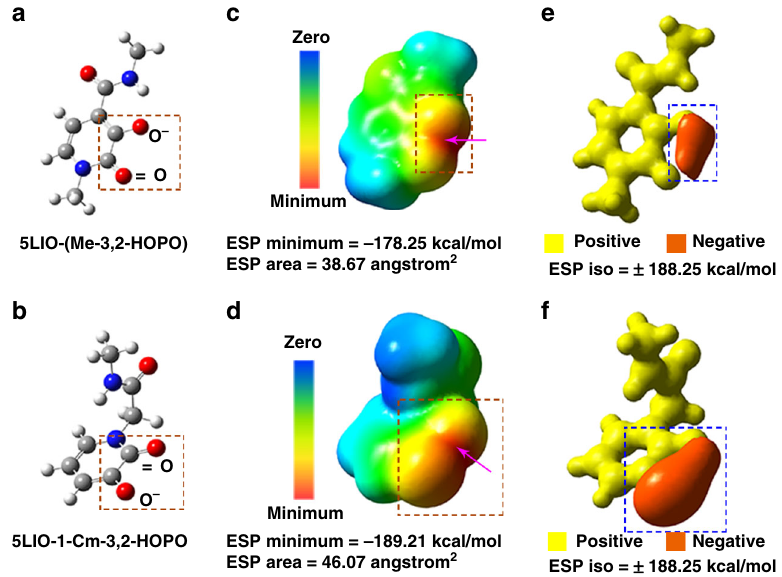
Fig. 3 The structural and electrostatic features of 5LIO-(Me-3,2-HOPO) and 5LIO-1-Cm-3,2-HOPO. a , b Represent the deprotonated structures of 5LIO- (Me-3,2-HOPO) and 5LIO-1-Cm-3,2-HOPO, respectively. The red dotted boxes highlight the inverted carbonyl group and deprotonated hydroxyl group of the pyridinone ring. c , d Represent the ESP distributed on the electron density surface of a , b (isodensity = 0.001 a.u.). The arrows denote the global ESP minima. The red dotted boxes surround the major negative ESP areas. The negative ESP areas contributed by the two oxygen atoms were calculated and are shown below ( c , d). e , f Represent the ESP isosurfaces at + / − 188.25 kcal mol − 1 . The blue dotted boxes surround the major spatial distribution regions at the speci fi c ESP